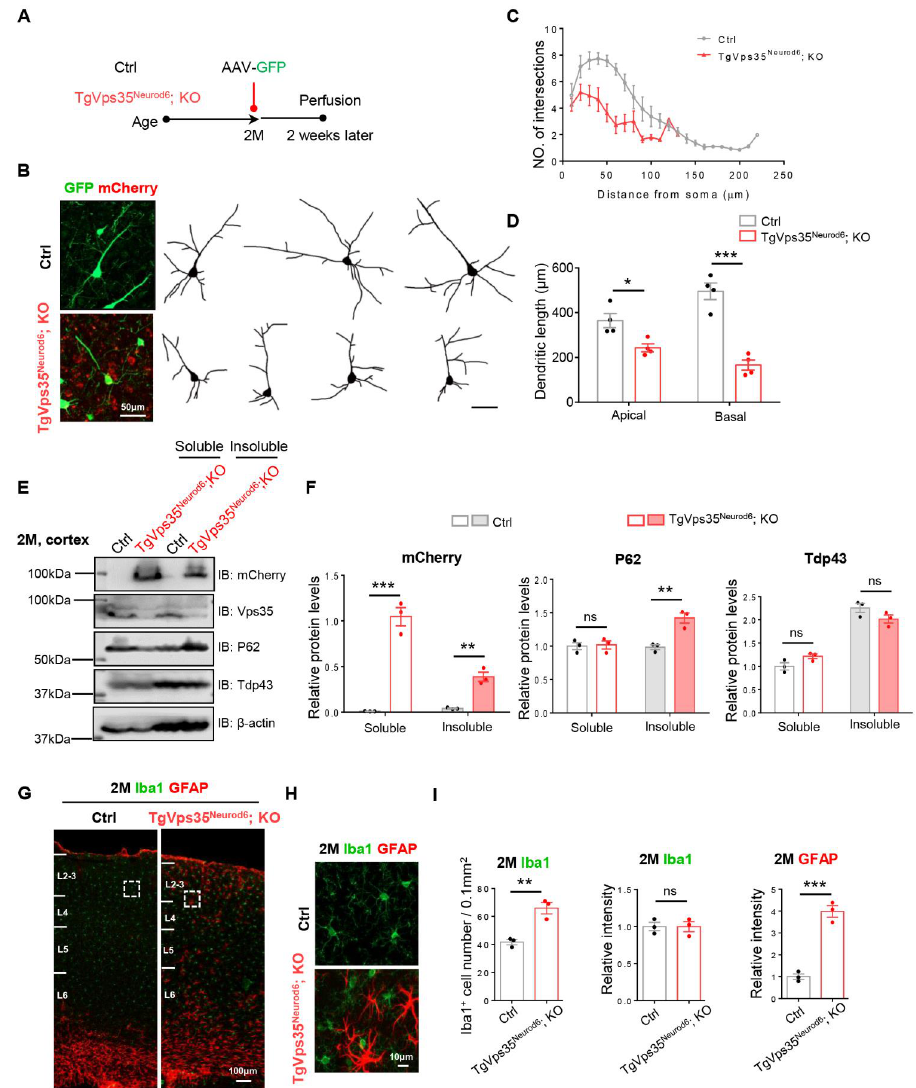
Figure 5. Terminal differentiation deficits, FTD (frontotemporal dementia)-like neuropathology, and increased GFAP + reactive astrocytes and Iba1 + microglia in TgVps35 Neurod6 ; KO cortex. ( A ) Time graph illustrating the process of AAV-Syn-GFP injection in control ( Vps35 f/f ) and TgVps35 Neurod6 ; KO mice. ( B ) Representative images and tracing of single neuron labelled with GFP from L2-3 of control and TgVps35 Neurod6 ; KO mice. ( C , D ) Quantification shows decreased dendritic complexity by Sholl analysis and a reduction of apical and basal dendrites length ( n = 4 neurons from three mice per genotype; two-tailed unpaired t-test). ( E , F ) Western blot analyses and quantification analysis of relative protein expression levels from E ( n = 3 animals per genotype; two-tailed unpaired t-test). ( G , H ) Representative images of immunostaining analysis using indicated antibodies in 2-months-old neocortical sections from mice with labelled genotype. Higher-magnification images of the boxed regions were shown in offside panels. ( I ) Quantification of immunofluorescence from G,H. ( n = 3 animals per genotype; two-tailed unpaired t -test). Scale bars as indicated in each panel. Individual data points were shown as dots with group mean ± S.E.M; * p < 0.05; ** p < 0.01; *** p < 0.001; n.s.: Not